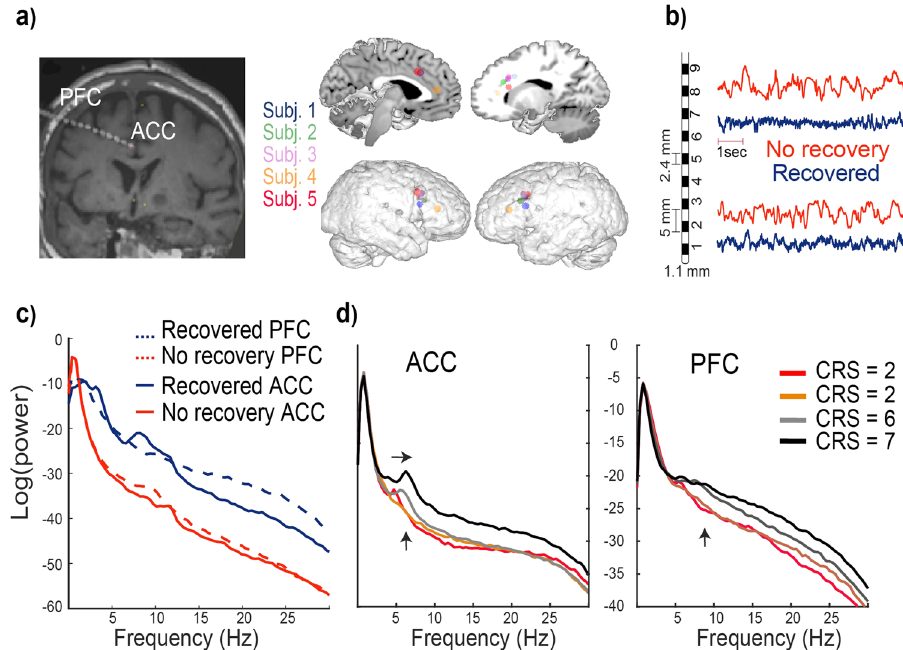
Fig. 1 LFP activity distinguishes coma, wakefulness, and the transition from one state to another. a Left: a depth electrode is placed to provide direct recordings throughout PFC and ACC. The depth electrode location is shown on a T1-weighted coronal MRI. All electrodes were right-sided, except for Subject 2, whose electrode was on the left. Right: locations of electrodes from external and internal sagittal slices for all the patients. b , c Representative LFP recordings and their associated power spectral density recorded from PFC and ACC from the patient who recovered (Subject 1, CRS-R~2 − 10) versus the deeply comatose patient who did not recover (Subject 5, CRS-R~0-2). Note that the wakefulness exhibits spatially distinctive peaks in the ACC (theta and alpha) and PFC (delta and beta). d A patient who recovered consciousness over days of recordings (Subject 2) showed a gradual shift of the ACC theta peak towards higher frequencies and increased beta power in the PFC (black